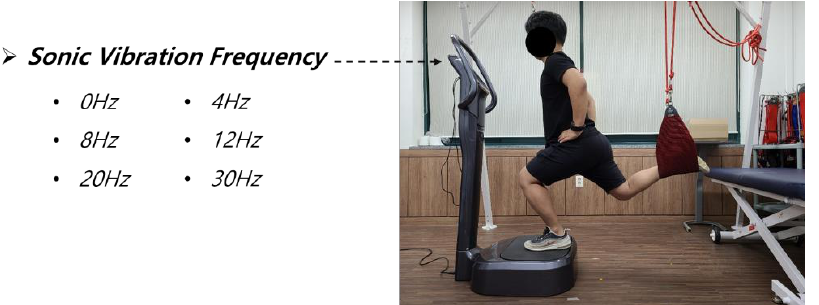
Figure 1. Bulgarian split squat using a sling according to the vibration frequency condition.